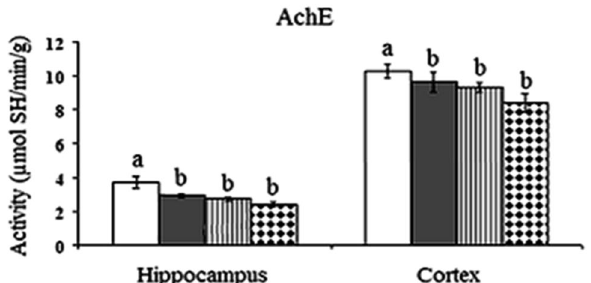
Figure 9. Effect of different doses of green synthesized silver nanoparticles (AgNPs) (0.5 mg/kg, 5 mg/kg, and 10 mg/kg) on the activity of acetylcholinesterase (AchE) hippocampus and cortex of rat brain. Control, Rats treated with AgNPs (0.5 mg/kg), Rats treated with AgNPs (5 mg/kg), Rats treated with AgNPs (10 mg/kg). Statistically significant means (p-value < 0.05) are given different letters and the same letters indicate non-significant